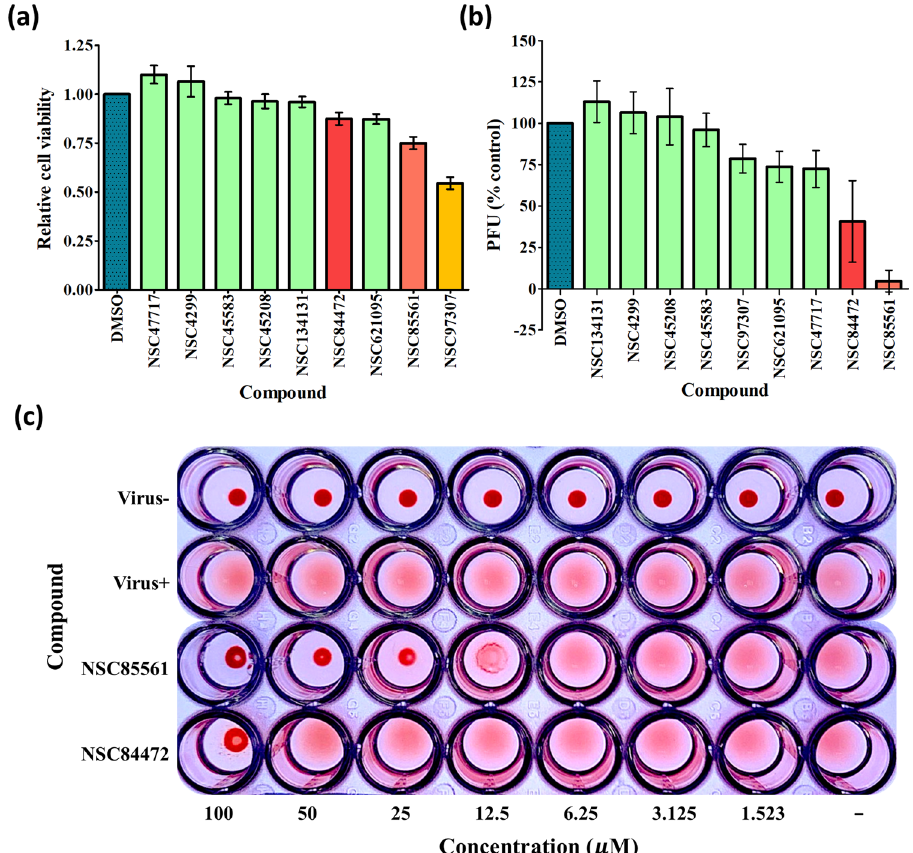
Figure 3. Identification of NSC85561 from the initial compounds. (a) MDCK cells were treated with the initial nine compounds at the concentration of 100 µM and cell viability was measured using the MTS assay. (b) MDCK cells were infected with A/WSN/1933 (H1N1, 100 PFU) were treated with the mixture at the concentration of 25 µM. A virus plaque reduction assay was performed. (c) Representation of the agglutination of NSC85561 and NSC84472 in serial two-fold dilutions started with 100 µM and was performed in three individual experiments.